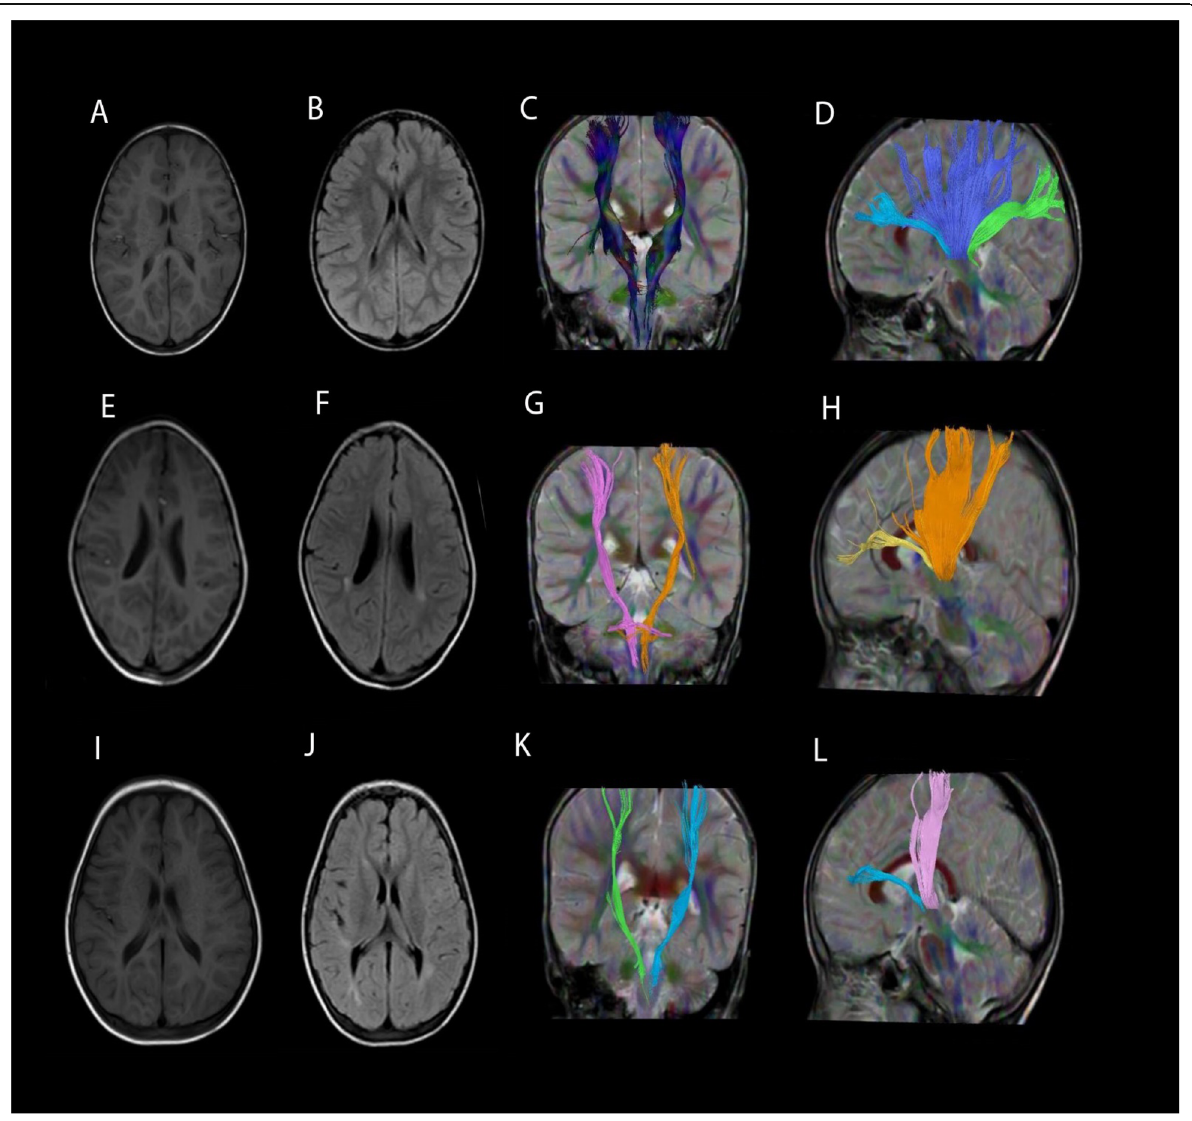
Fig. 3 Comparison between control, lower grades, and higher grades of GMFCS; control case 1st row ( a , b ) T1 WI and FLAIR images show normal study; c normal CST and d normal ATR (light blue colored), STR (blue colored), and PTR (green colored). Second row represents a case with mild motor affection (GMFCS II) with e , f T1 WI and FLAIR images revealed mild PVL; g mild thinning of CST, h mild thinning of STR (orange colored) and ATR (yellow colored) and absent PTR. Third row represents the case with severe motor affection with (GMFCS IV); i , j T1 WI and FLAI R images revealed mild PVL; k mild thinning of CST (more on right side) with l moderate tinning of STR (pink colored) and ATR (light blue colored) and absent